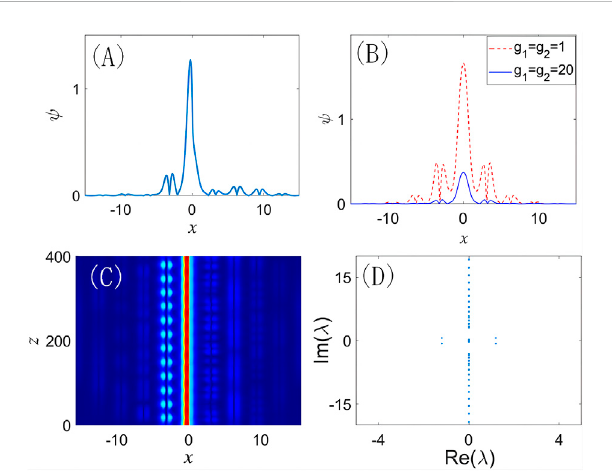
FIGURE 2 (Color online) First-gap localized modes under propagation constant β (cid:1) − 1 . 8. (A) Intensity pro fi les of stable localized mode in non- uniform nonlinearity. (B) Pro fi les of localized modes supported by one- dimensional photonic lattices and different constant nonlinear types (the red dotted line and blue dash line are uniform non-linearities with nonlinear coef fi cients of 1 and 20 respectively). (C) Evolution of the localizedmodewiththetransmissiondistanceof z (cid:1) 400. (D) Eigenvalue spectrum of linear stability analysis for the localized mode in (A) .